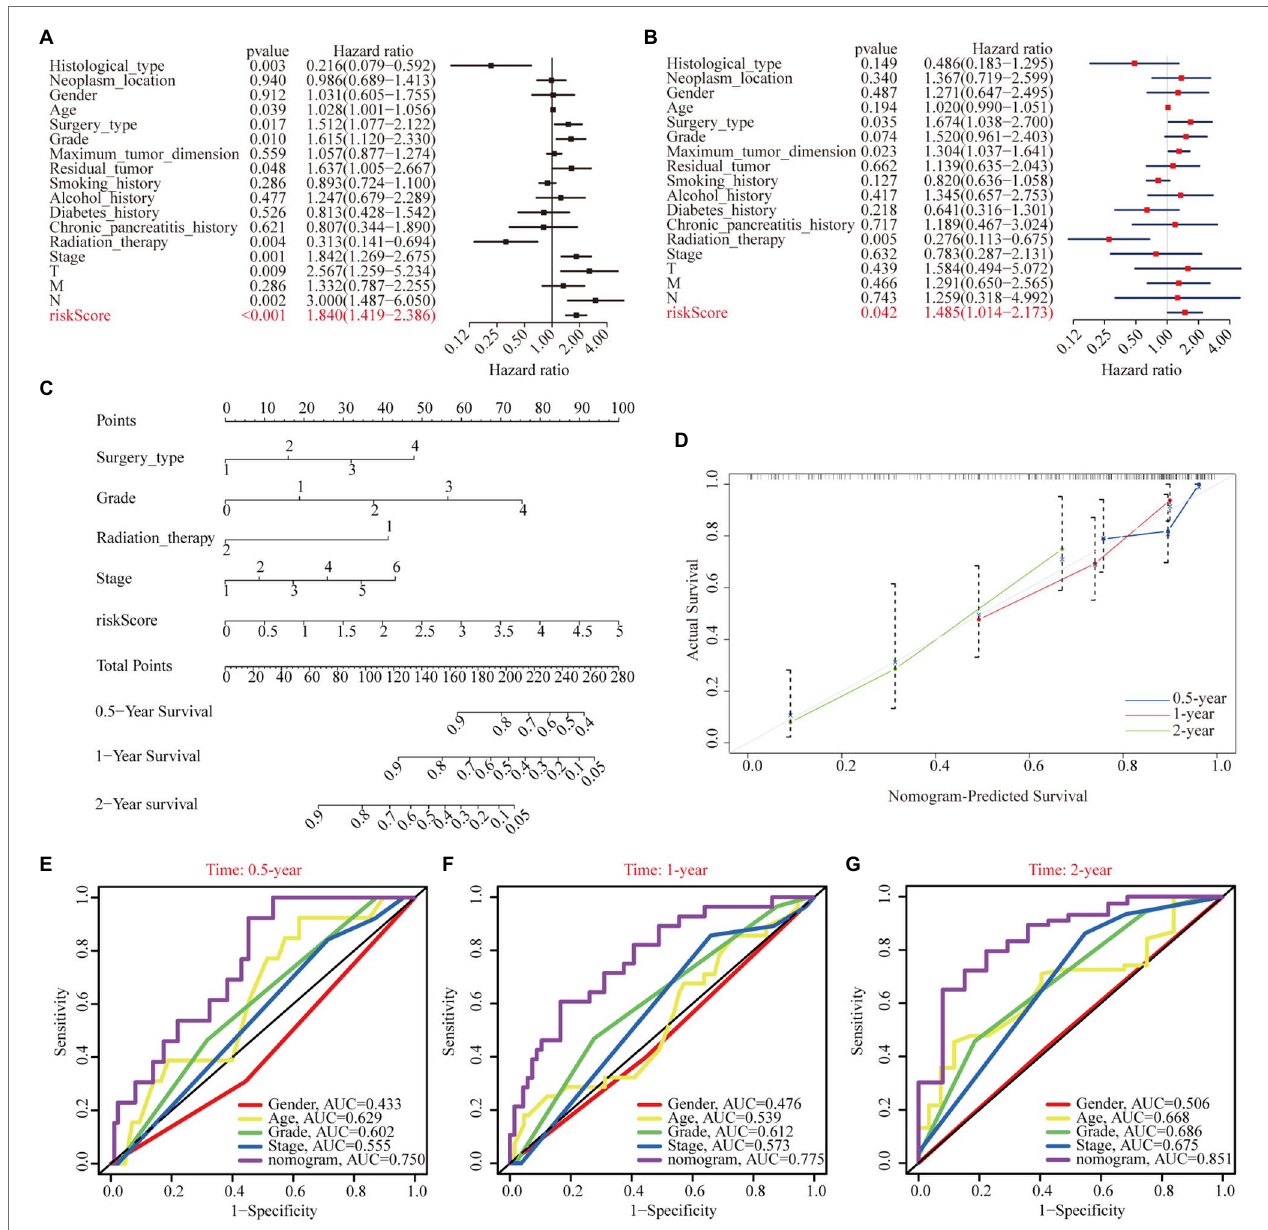
FIGURE 8 | Independent prognostic analysis of risk scores. (A) Univariate Cox regression analyses of the association among risk score, clinicopathological parameters, and OS of patients in the TCGA cohort. (B) Multivariate Cox regression analyses of the association among risk score, clinicopathological parameters, and OS of patients in the TCGA cohort. (C) The nomogram composed of surgery type, histological grade, radiation therapy, stage, and risk score for the prediction of 0.5-, 1-, and 2-year OS probability. (D) The calibration plot for the evaluation of the nomogram in predicting 0.5-, 1-, and 2-year OS probability. The multi-index ROC curves integrating nomogram, age, sex, grade, and stage for the prediction of 0.5-year (E) , 1-year (F) , and 2-year (G) OS